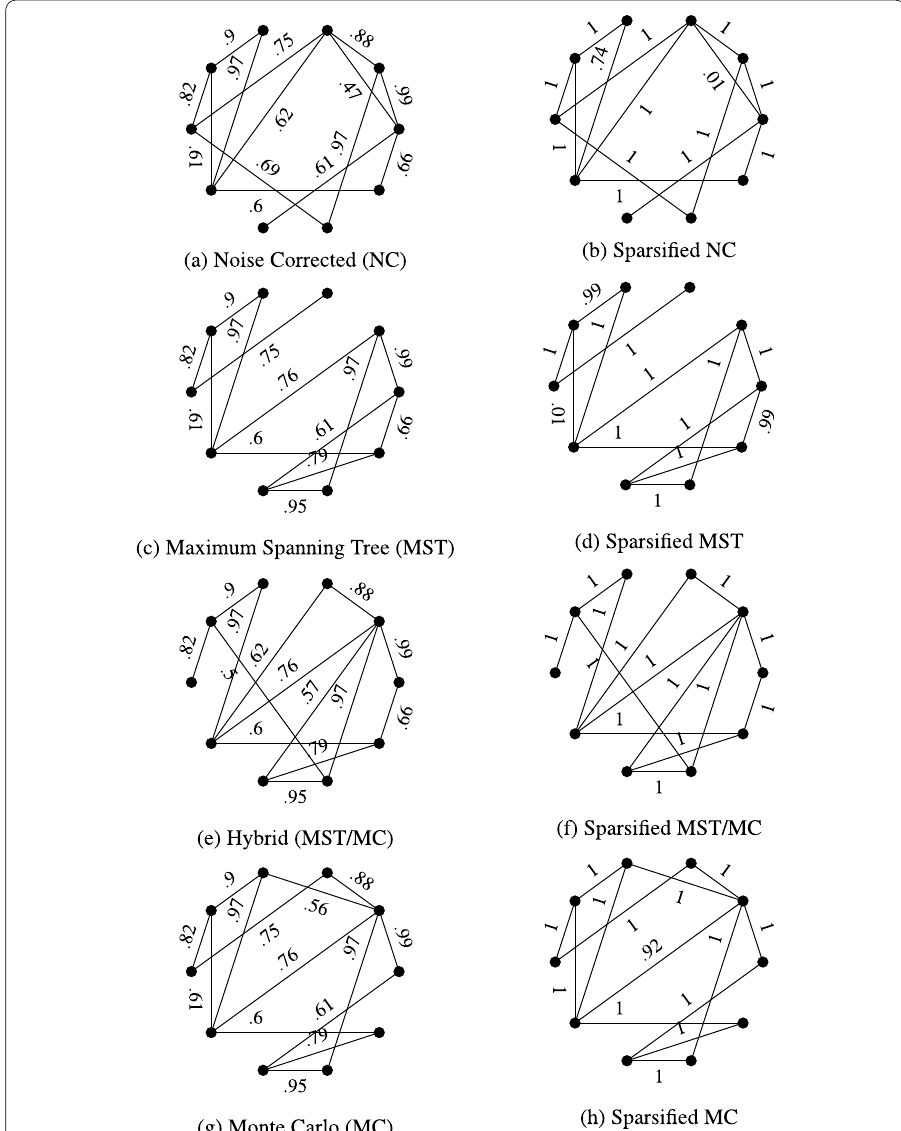
Fig. 3 (First column) Backbones of the original graph in Fig. 2 have been extracted with the methods explained in “Backboning” section (second column) Sparsified graphs of the corresponding backbones resulting from Algorithm 1